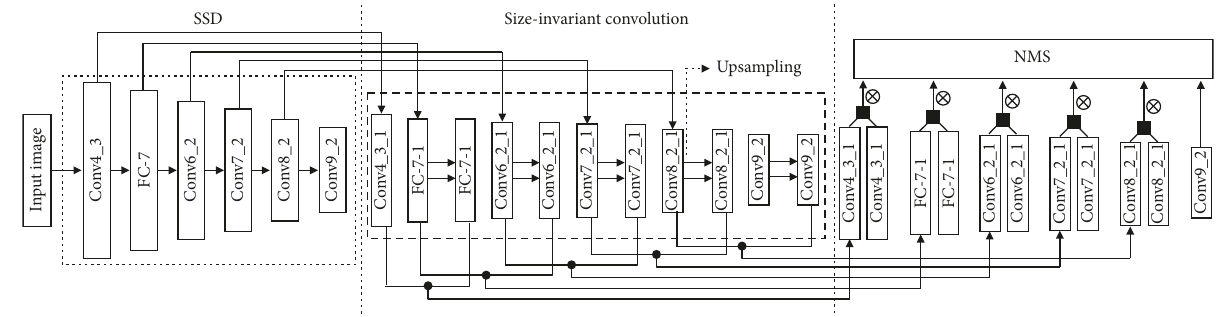
Figure 4: Structure of the feature pyramid-enhanced fusion SSD algorithm.